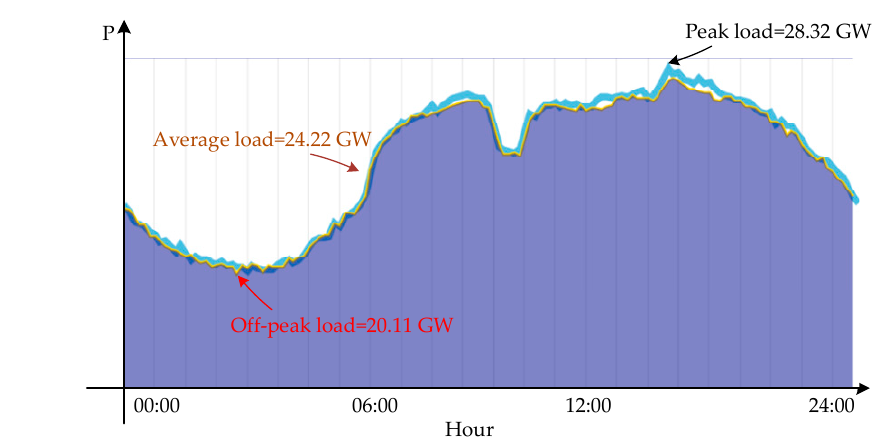
Figure 6. Daily load curve on 26 December 2017 of the Taipower system.